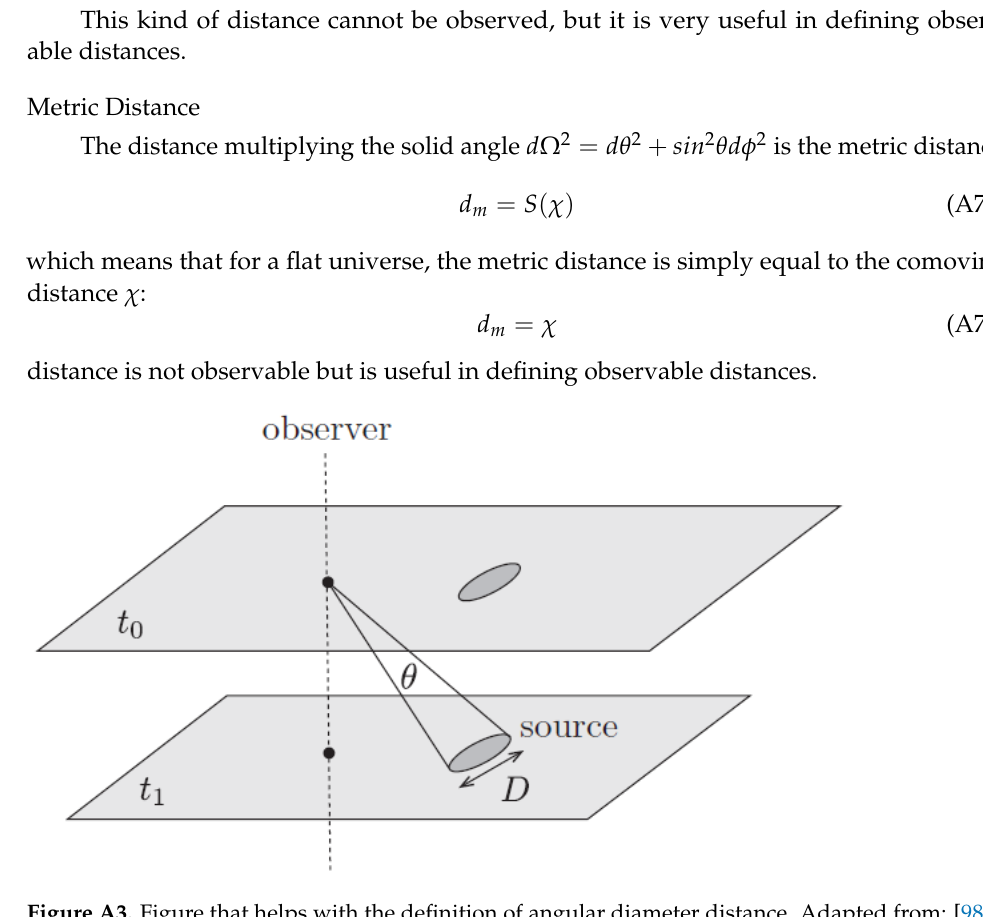
Figure A3. Figure that helps with the definition of angular diameter distance. Adapted from: